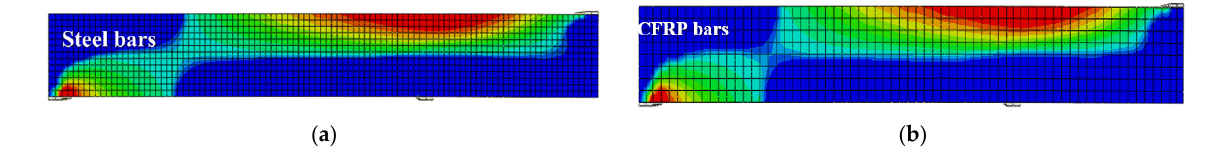
Figure 11. Crack pattern at 0.15% reinforcement ratio: ( a ) Steel and ( b ) CFRP beams.